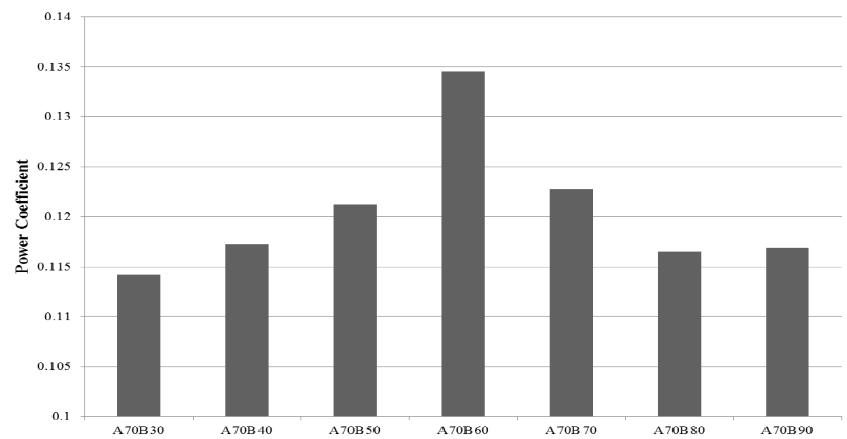
Figure 17. Effect of guide vane B angle on power coefficient.